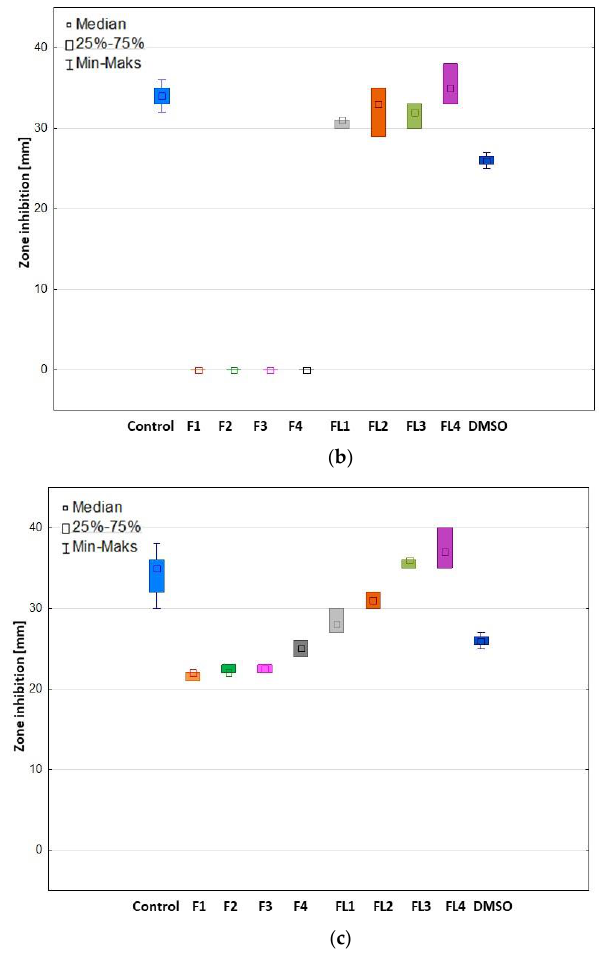
Figure 13. Antifungal action of microparticle placebo formulations (formulations F1 – F4) and LUL-loaded microparticles formulations (formulations FL1 – FL4); LUL/DMSO (Control) against ( a ) C. albicans , ( b ) C. krusei , and ( c ) C. parapsilosis (n = 3).